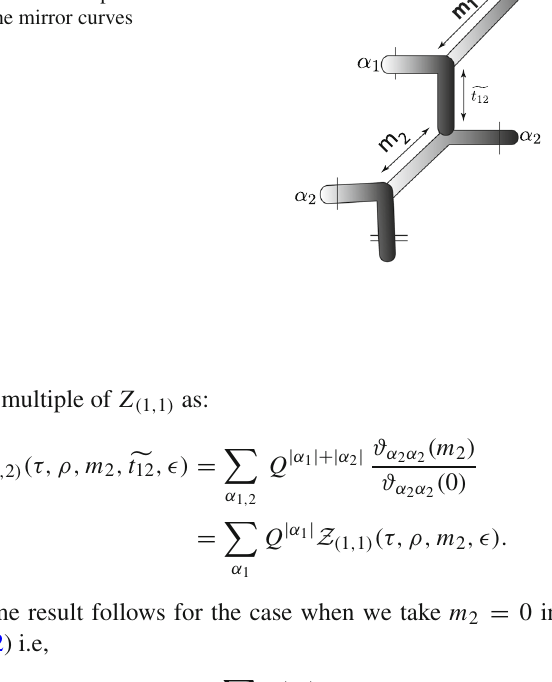
Fig. 7 Two possible degenerations of the partition function Z 1 , 2 . The third column depicts 3D/non-planar structure of the mirror curves